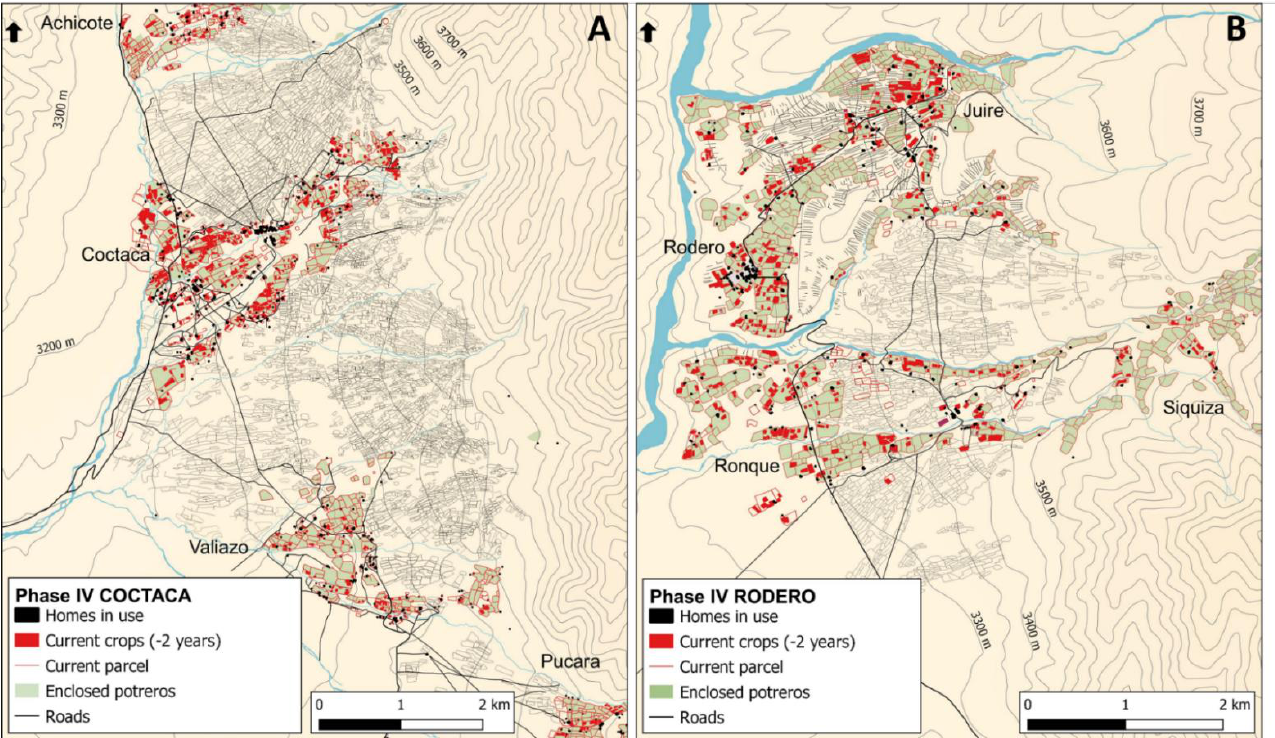
Figure 9. Current land use at ( A ) Coctaca and ( B ) Rodero.